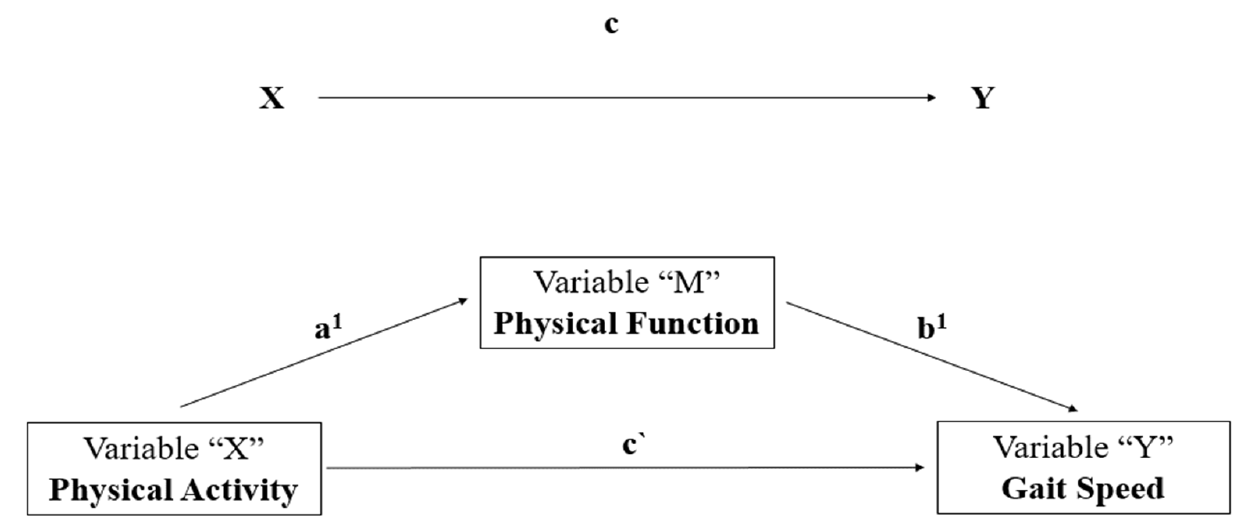
Figure 2. Linear mediation relationships to examine the mediating role of PF in the relationship between PA and GS. Path (a) = association between PA-Activity (X) with mediator (M) Physical Function (Y), Path (b) = association between mediator (M) Physical Function with Gait Speed (Y), Path c’ = direct effect (X-Y).